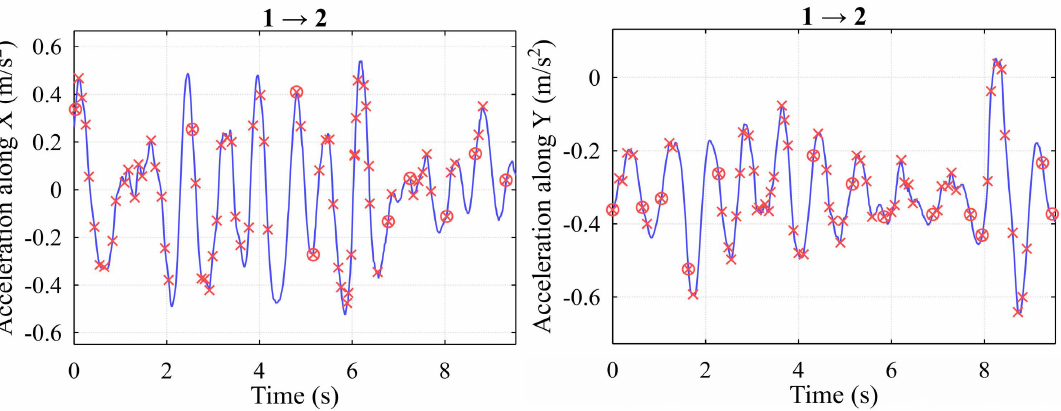
tional impact detected in the first use case along the Y-axis (refer to Figure 12).